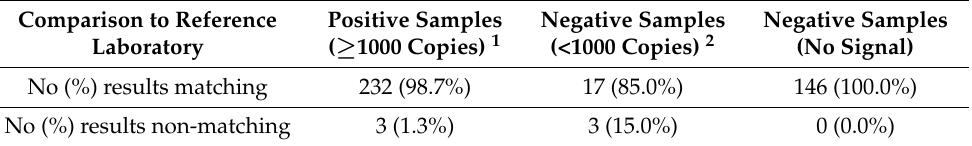
Table 1. Results comparing the total number and percent of results of Gannon COVID-19 testing to that of an independent CLIA certified reference